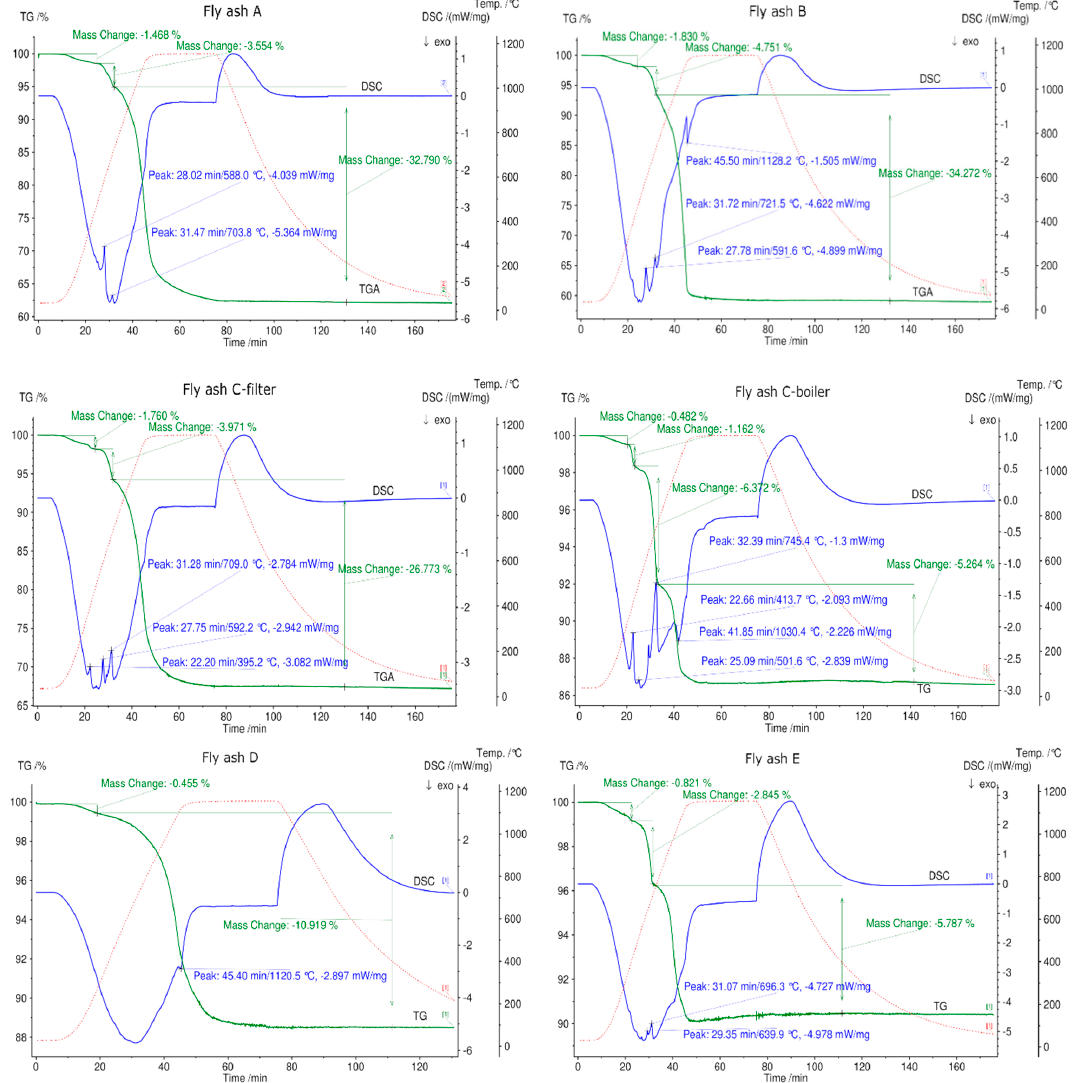
Figure 7. STA results for all fly ash samples in a N 2 atmosphere between 30 °C and 1150 °C. The green line denotes percentage mass loss, blue line denotes DSC trace, and dotted red line denotes temperature profile.